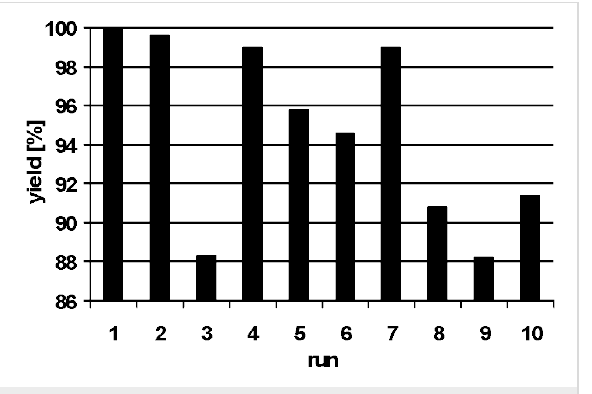
Figure 2: Repeated Suzuki reaction of 4-bromotoluene ( 6 ) with phenylboronic acid ( 10 ) under flow conditions. Deviations may result from work up as only isolated yields are presented.